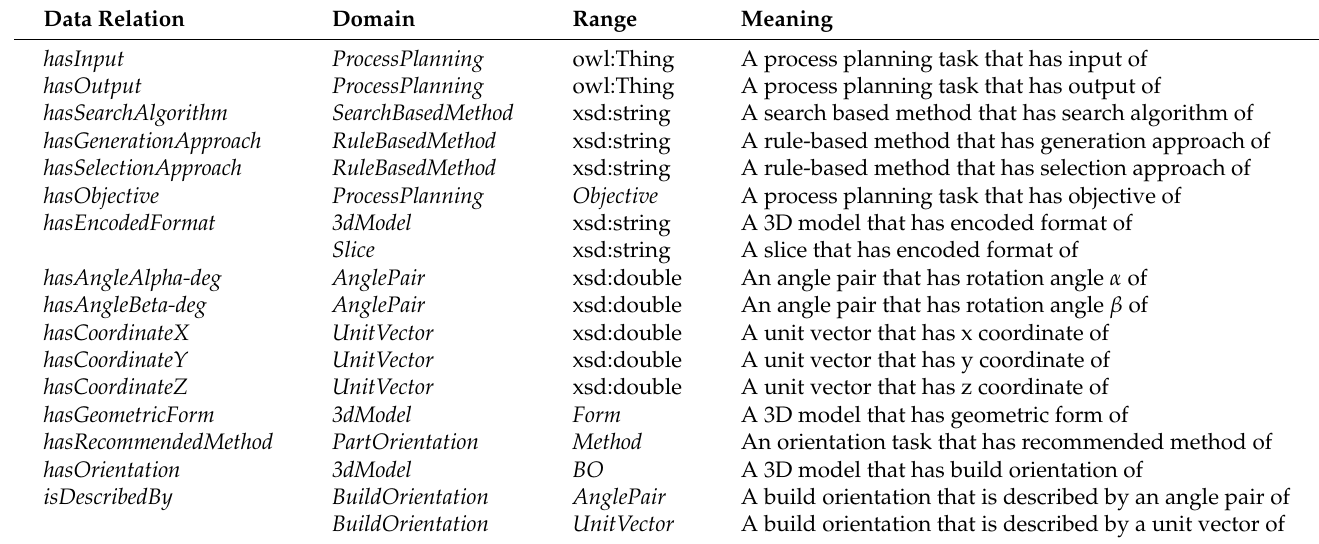
Table 4. Domain, range, and meaning of sixteen relations in part orientation.